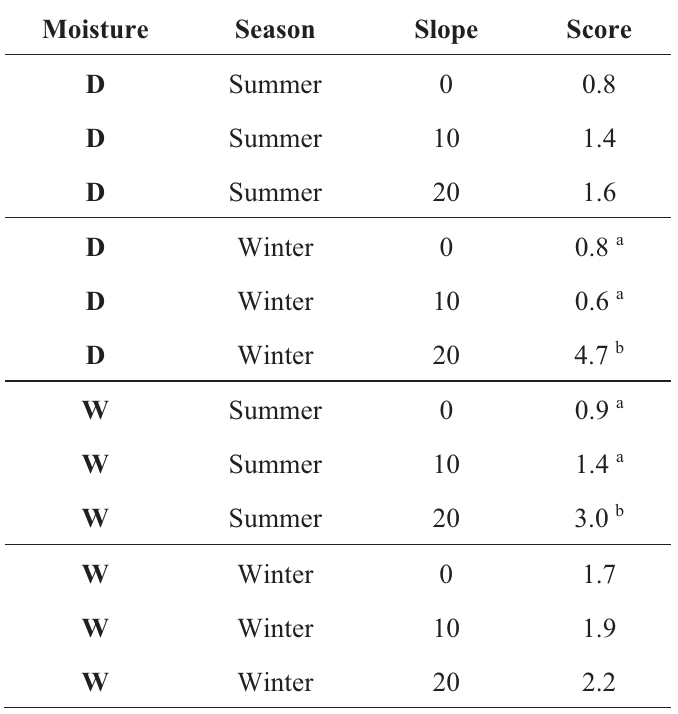
Table 2. Least Squares means ± 0.82 for weaned pig scores in response to the 3-way interaction for moisture (D = Dry, W = Wet), season, and slope ( P < 0.05). Score was calculated by the sum of slips, falls, and vocalizations. n = 60